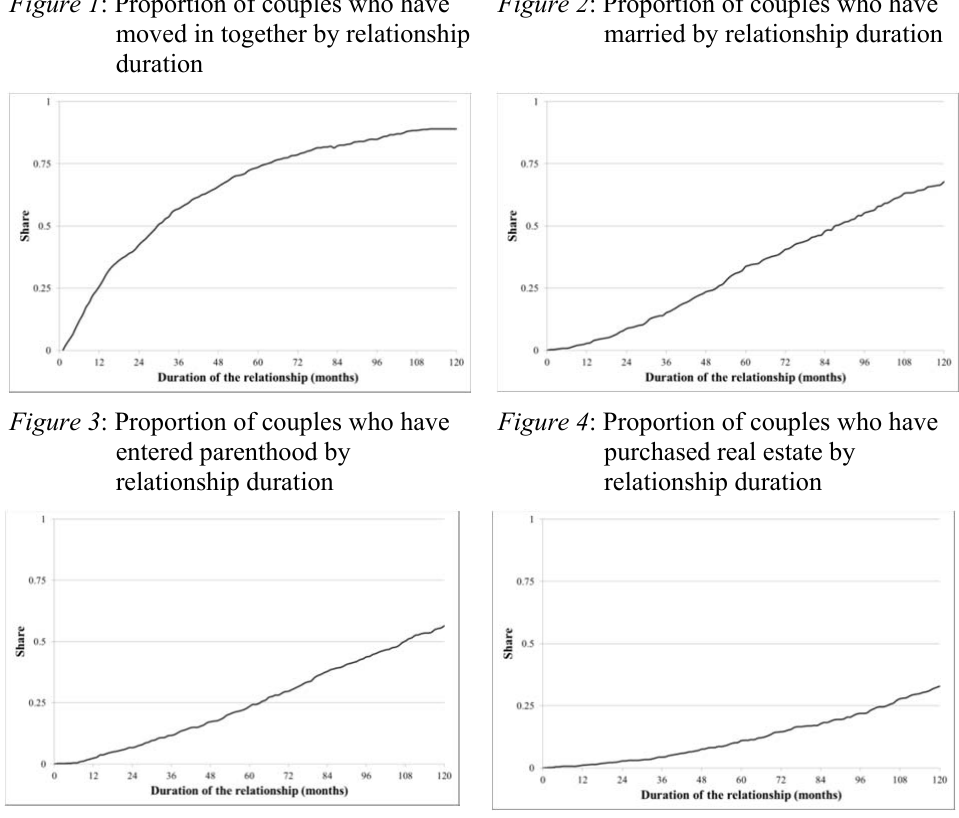
Figure 2 : Proportion of couples who have married by relationship duration